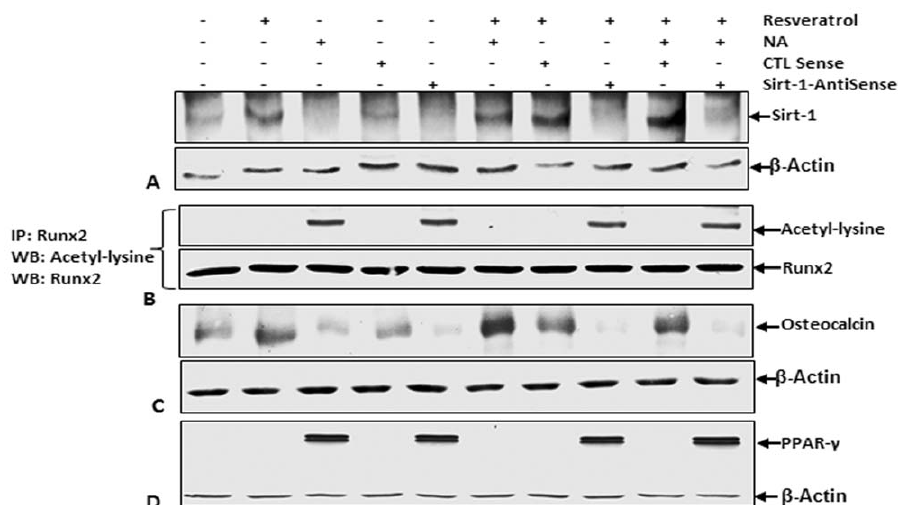
Figure 8. Effect of resveratrol on nicotinamide and/or antisense oligonucleotide-induced specific inhibition of Sirt-1 expression, Runx2 acetylation, Runx2 target genes (i.e.osteocalcin) or activation of PPAR- c during osteoblastic differentiation of MSCs in monolayer culture. Cells were either untreated or treated with resveratrol (1 m M), nicotinamide (10 mM) or with Sirt-1 antisense (1 m M) or sense oligonucleotides (1 m M) in the presence of lipofectin alone or cells were pre-treated with resveratrol for 4 h followed by co-treatment with Sirt-1 antisense or sense oligonucleotides in the presence of lipofectin for 24 h or/and with nicotinamide over 21 days with osteogenic induction medium in monolayer cultures. (A) Whole cell lysates (500 ng/lane) were fractionated and subjected to western blotting with antibodies against Sirt-1 and b - actin. Synthesis of the housekeeping protein b -actin was unaffected. (B) Whole-cell extracts were prepared, immunoprecipitated with an anti-Runx2 antibody, and subjected to western blot analysis using an anti–acetyl-lysine antibody. The same blots were re-probed with an antibody to anti-Runx2. Whole cell lysates (500 ng/lane) were fractionated and analyzed by immunoblotting using anti-osteocalcin (C) or anti-PPAR- c (D) antibodies and b - actin. Synthesis of the housekeeping protein b -actin was unaffected.